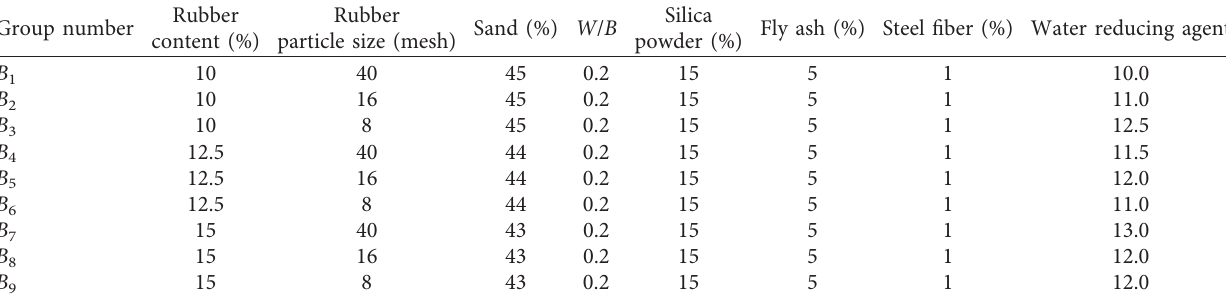
Table 5: Rubber UHPC mix proportion (kg/m 3